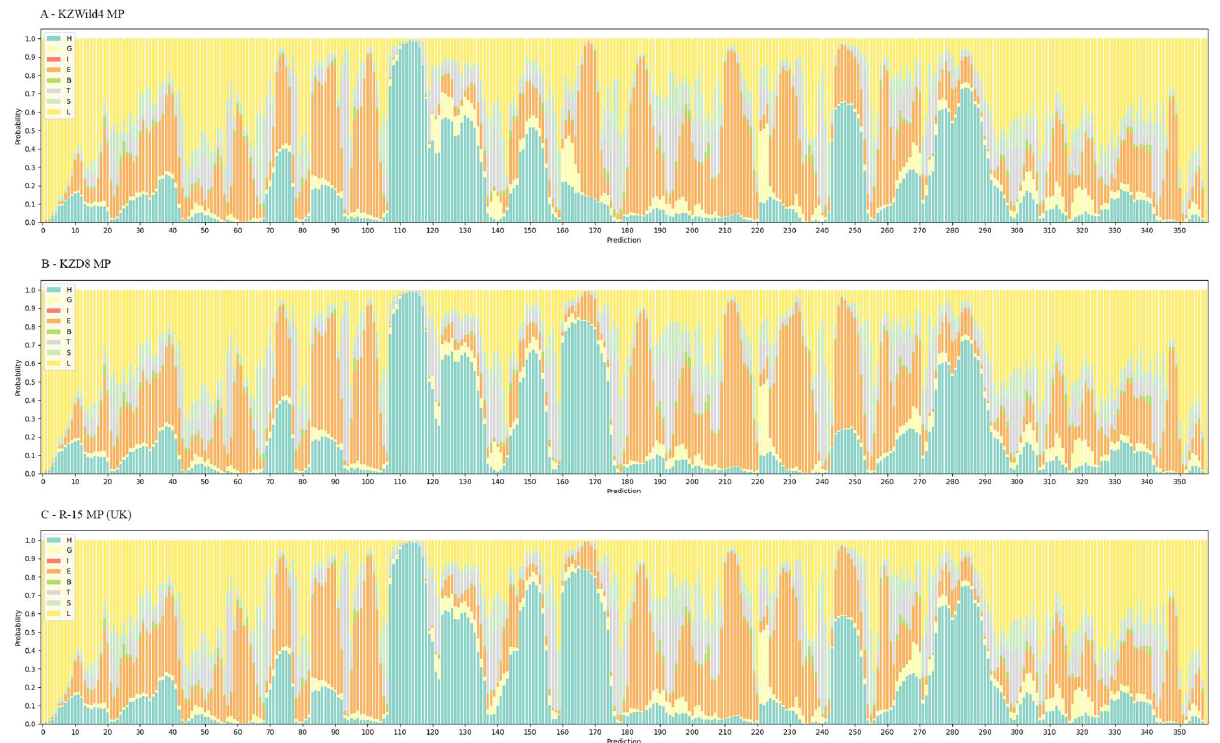
Figure 6. Protein Structure Property Prediction of KZWild4 MP, KZD8 MP and R-15 MP (reference) using SS8 DSSP notation. Note the prevalence of either E (extended strand, participating in β ladder) structures or H (α-helix) structures at 160–175 aa and 240–255 aa.